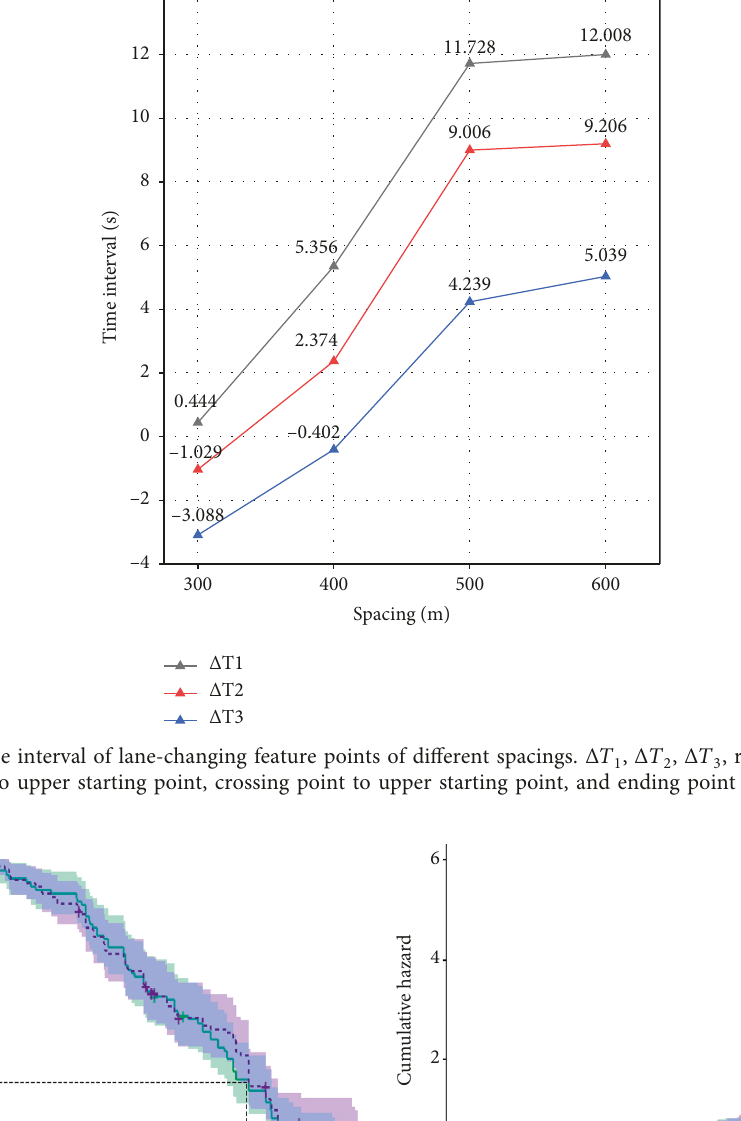
Figure 8: Distribution characteristics of MLCD under vehicle factors. (a) Cumulative survival function curve of vehicle types. (b) Cu- mulative hazard function curve of vehicle